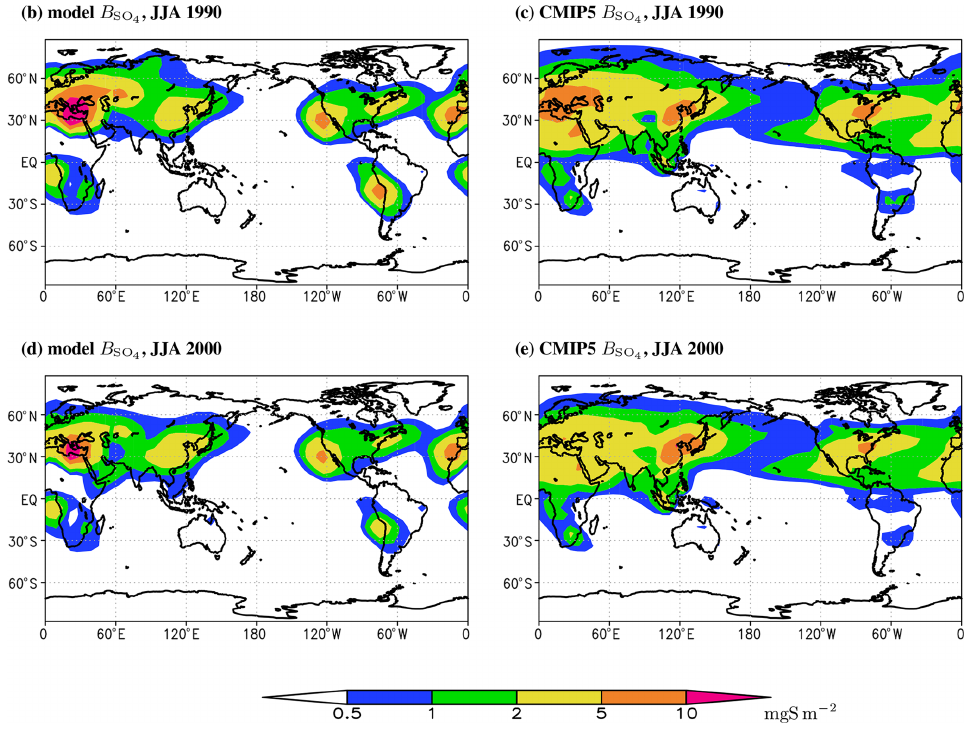
Figure 7. Similar to Fig. 6 but for means over